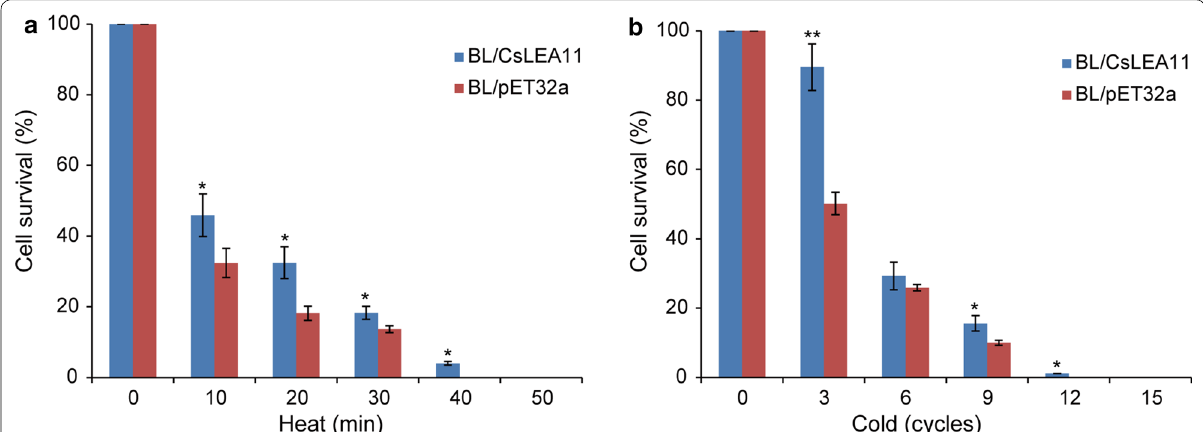
Fig. 6 Growth performance of BL/CsLEA11 and BL/pET32a cells under heat ( a ) and cold treatments ( b ). Error bars represent standard deviations generated from three replicate trials